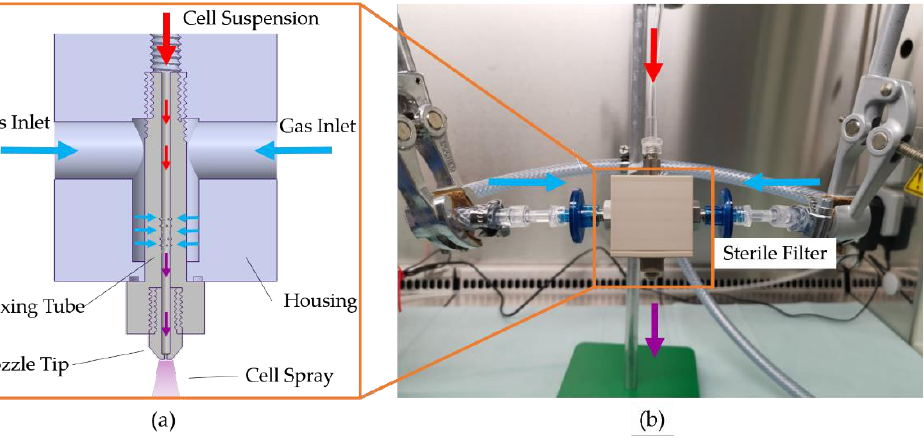
Figure 2. ( a ) Schematic of custom-made mixing tubes. ( b ) Three different designs: Mixing tubes A, B, and C. Scale bar: 10 mm.